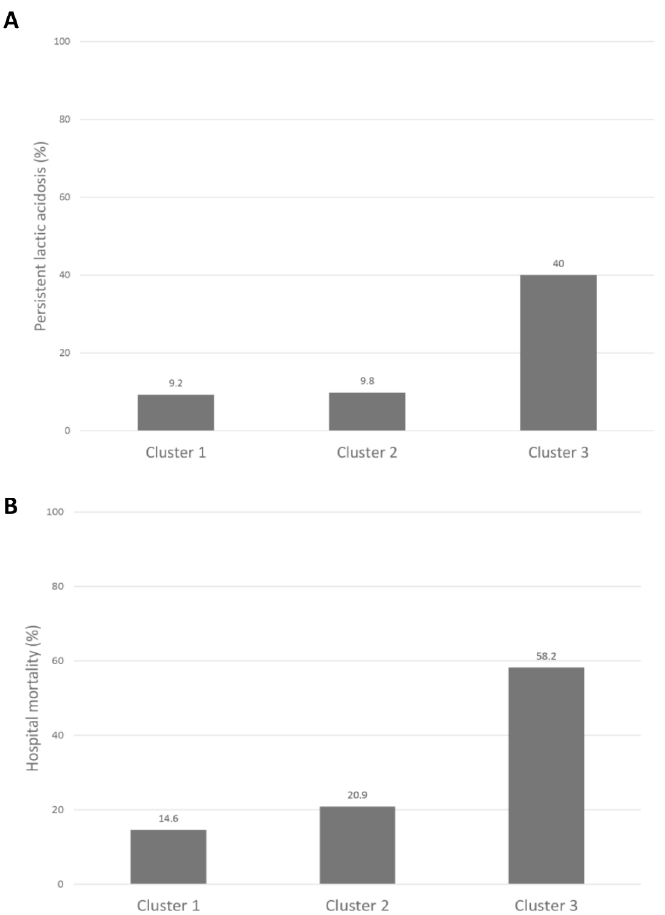
Figure 5. ( A ) Persistent lactic acidosis; and ( B ) hospital mortality among different clusters of ICU patients with lactic acidosis.